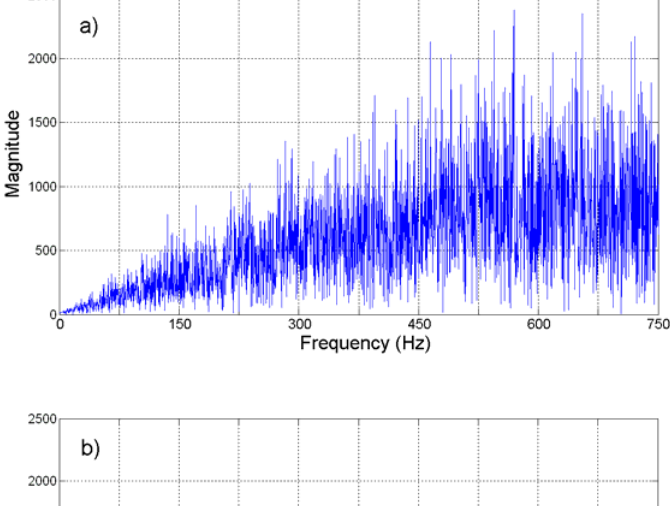
Figure 15. Direct decimation jerk error spectra. (a) Nyquist rate. (b) 4-times oversampling. (c) 8-times oversampling. (d) 16-times oversampling. (e) 32-times